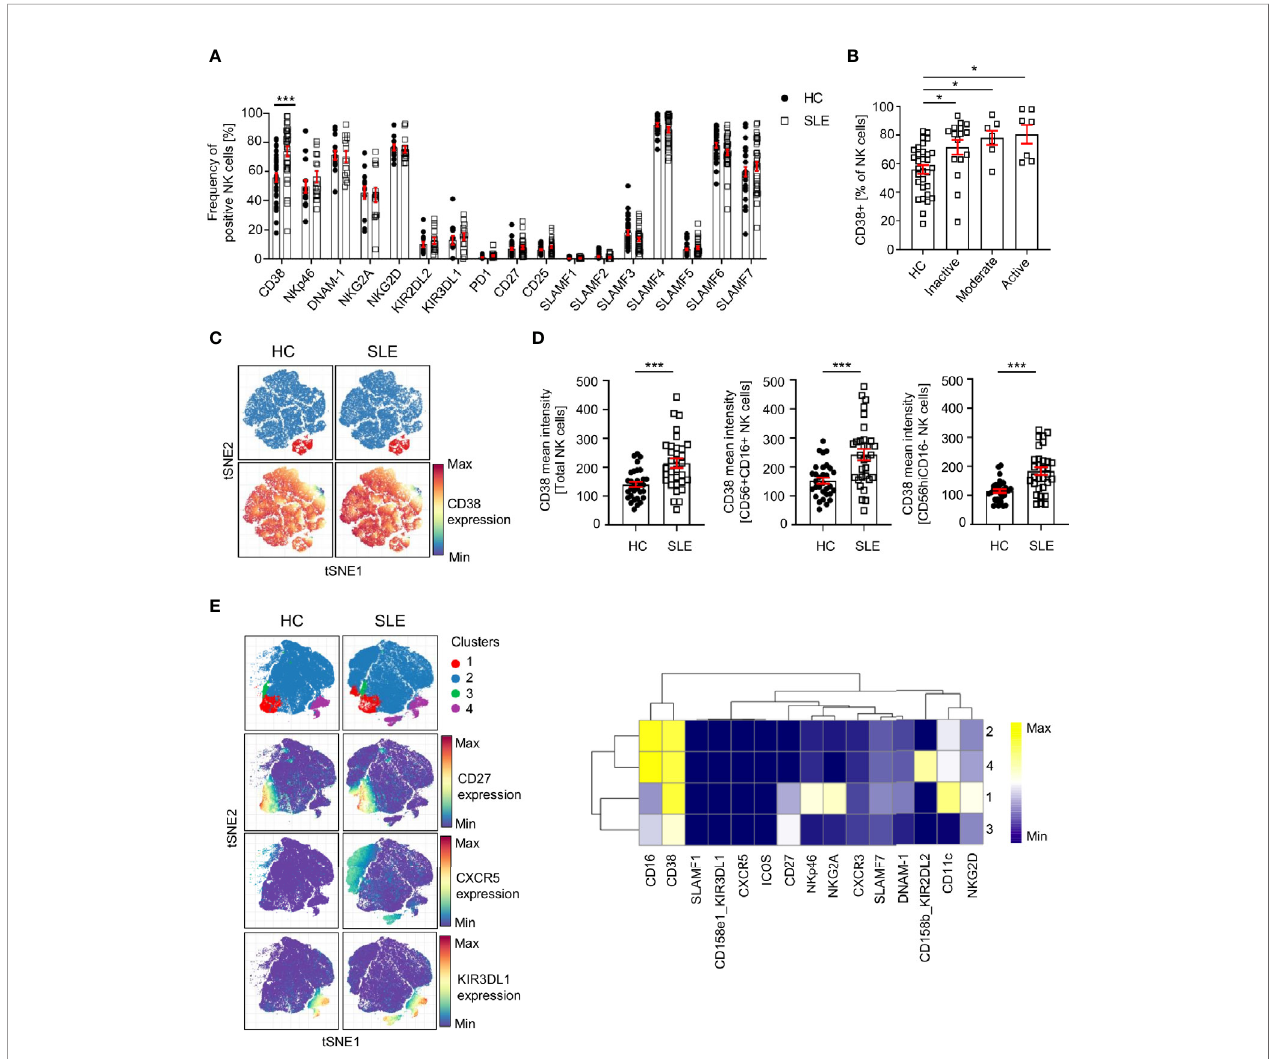
FIGURE 2 | Analysis of NK cell surface markers in SLE patients and controls by single-cell mass cytometry. (A) Percentage of NK cells expressing the indicated cell surface markers in HC and SLE (HC=33, SLE=33; two-way ANOVA and Sidak ’ s multiple comparison test). (B) Frequency of CD38+ NK cells in SLE patients according to the SLE disease activity (HC=31, Inactive=16, Moderate=7, Active=7; Kruskal-Wallis Test with Dunn ’ s multiple comparison test). (C) Representative t-SNE analysis showing the expression of CD38 on SLE and HC NK cells (down-sample HC=30 ’ 000 cells, SLE=30 ’ 000 cells; blue: CD56+CD16+ NK cells; red: CD56CD16hi NK cells). (D) Cumulative results showing the expression (mean intensity) of CD38 on total NK, CD56+CD16+ and CD56hiCD16- NK cells (HC=31, SLE=31; Mann-Whitney test). (E) t-SNE analysis (down-sample HC=10 ’ 000 cells, SLE=10 ’ 000 cells) and heatmap showing NK cell clusters in HC and SLE patients. Data represent mean ± SEM (*P < 0.05, ***P < 0.001). HC, healthy